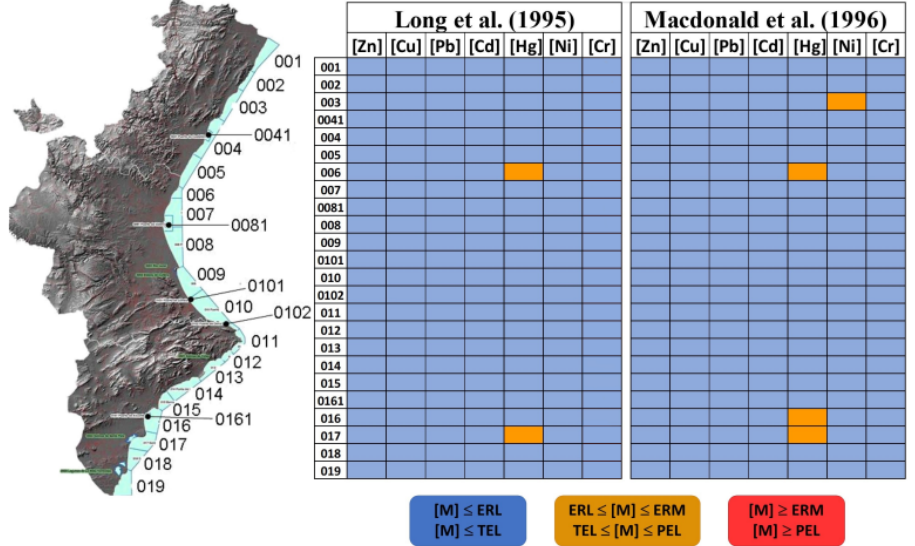
Figure 6. SQG result for all water bodies ([M]: Metal concentration; blue: [M] ≤ ERL and [M] ≤ TEL; orange: ERL ≤ [M] ≤ ERM and TEL ≤ [M] ≤ PEL; red [M] ≥ ERM and [M] ≥ PEL]).